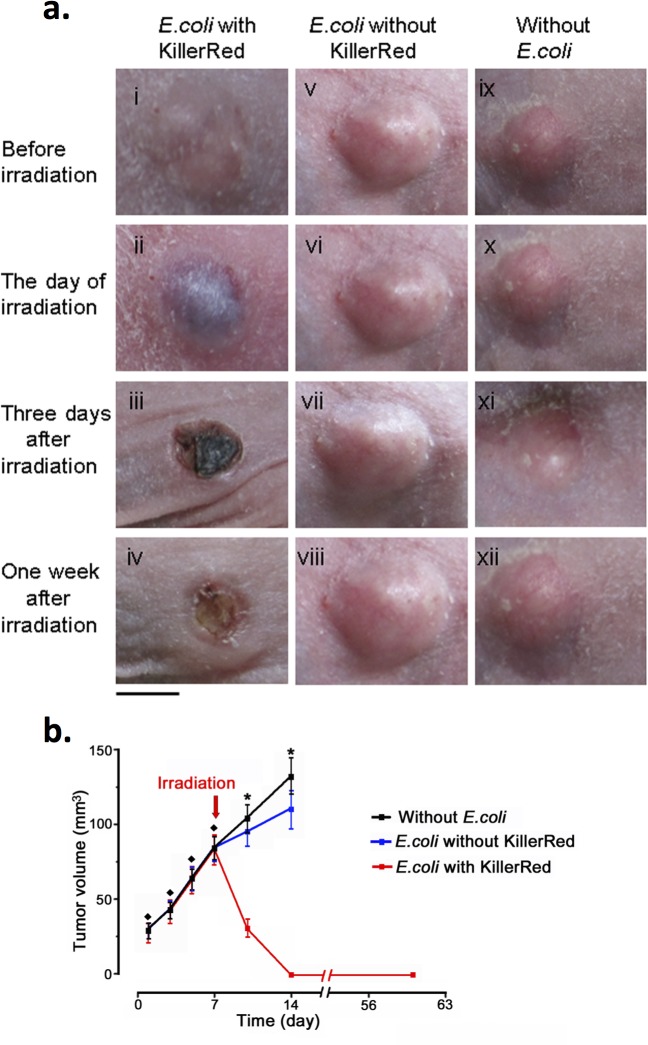
Effect of PDT with KR-E. coli on CNE2 tumors.
a, The left column represents the tumor (CNE2) injected with KR-E. coli and irradiated with the orange light. The middle column represents the tumor injected with wild type E. coli and irradiated with the orange light. The right column represents the tumor irradiated without E. coli injection (n = 12). Bar, 5 mm. b, Growth curves of tumors in the presence and absence of KillerRed-E. coli. The black line indicates the volume change of tumors irradiated without E. coli. The blue line indicates the volume change of tumors injected with E. coli that expressed no KillerRed. The red line indicates the volume change of tumors injected with E. coli that expressed KillerRed. All tumors were irradiated at the same dose on the day 7 after tumor cell transplantation (Day 1 after bacterial injection). Before treatment: ♦p > 0.05 (rank sum test). After treatment: *p < 0.01 (rank sum test). Error bars indicate SEM.